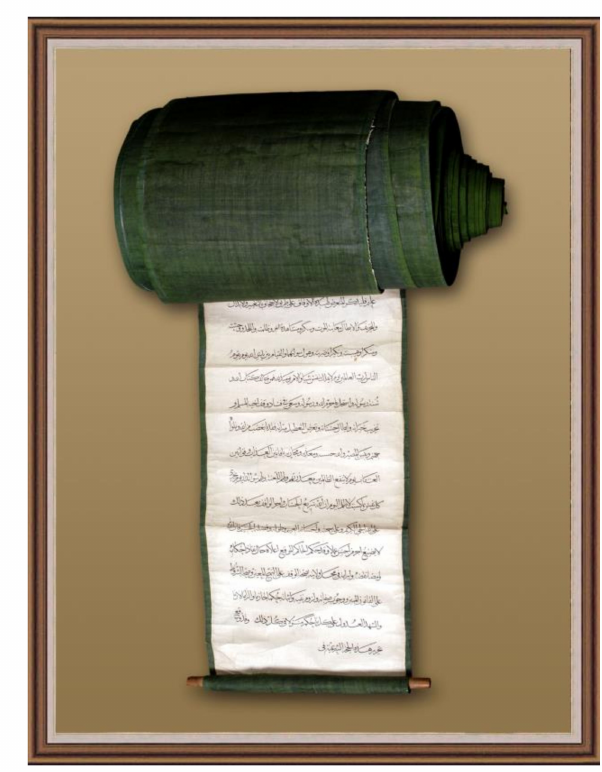
Figure 6. Foundation document of Hagia Sophia